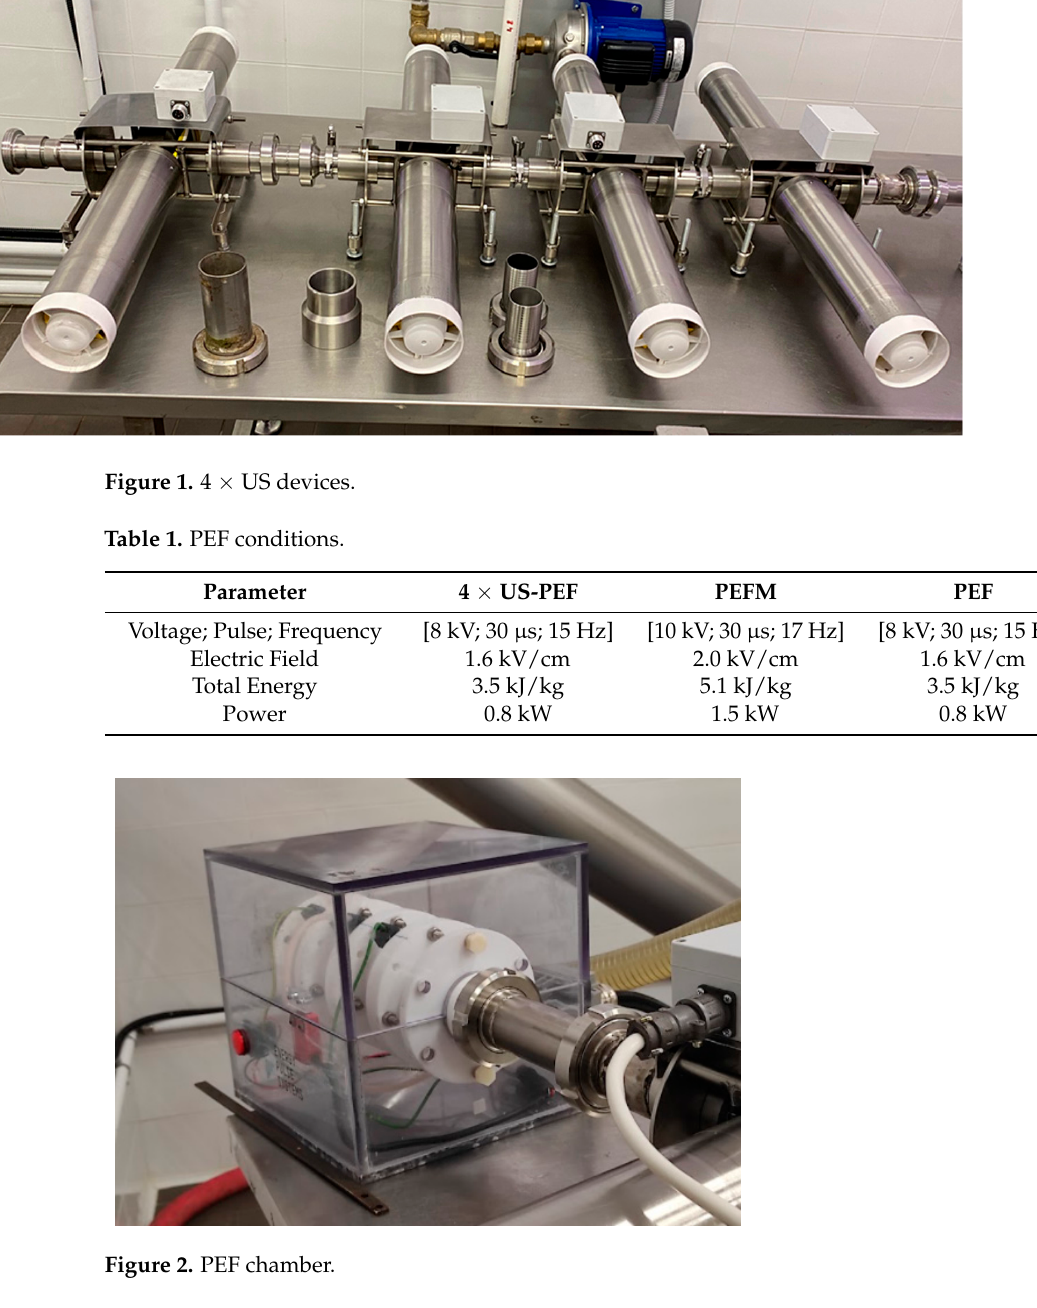
Figure 2. PEF chamber.